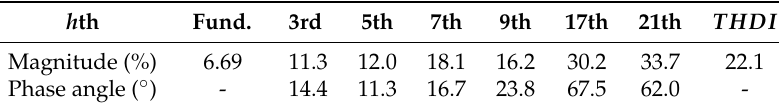
Table 1. NRMSE of magnitudes and RMSE of phase angles for harmonic currents between the time | and the mean of | I s | . series of | I m h h